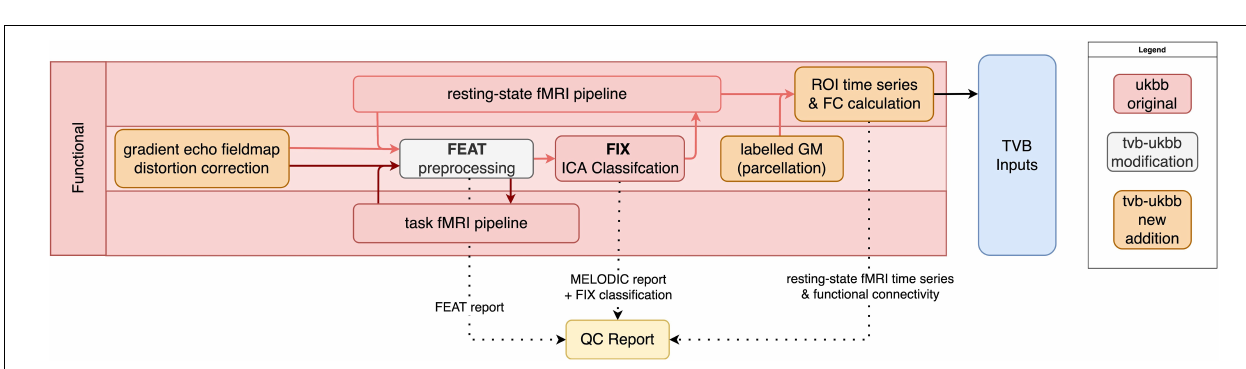
FIGURE 3 | fMRI sub-pipeline workflow. Original components of the UK Biobank pipeline with few or no modifications shown in red; pipeline components with major changes or additions shown in white; and new components shown in orange. Dotted lines indicate components that are included in the QC report. Black lines indicate components that are included in the TVB